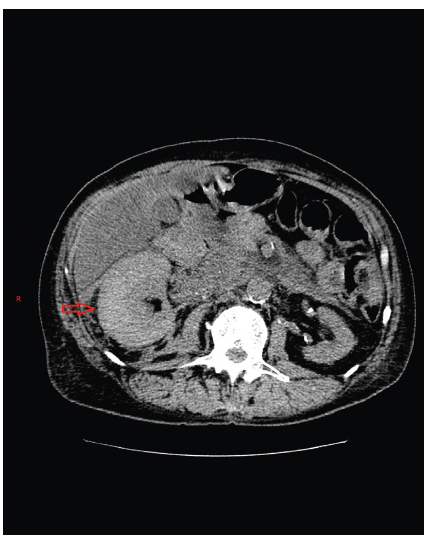
Figure 1: Axial section of noncontrast CT scan of the abdomen showing an enlarged right kidney (marked in red arrow) suggesting a potential collection within or outside the renal capsule.